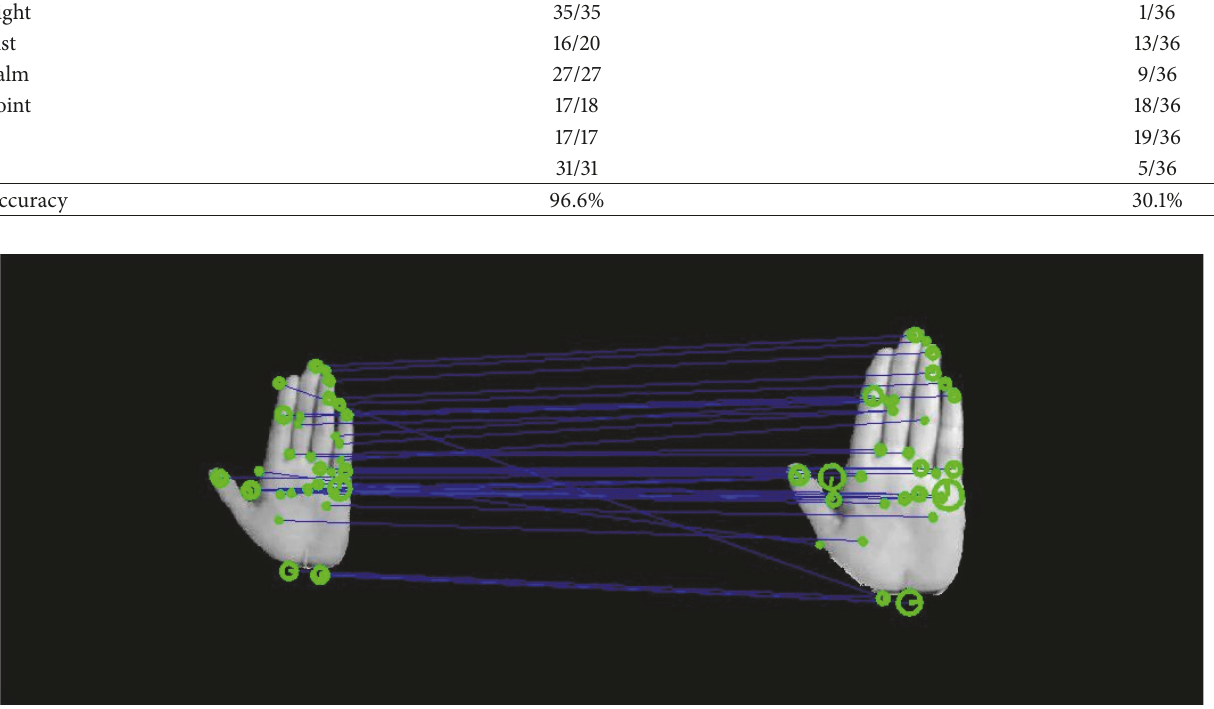
Figure 21: The matching feature points detected by SIFT on two palms.